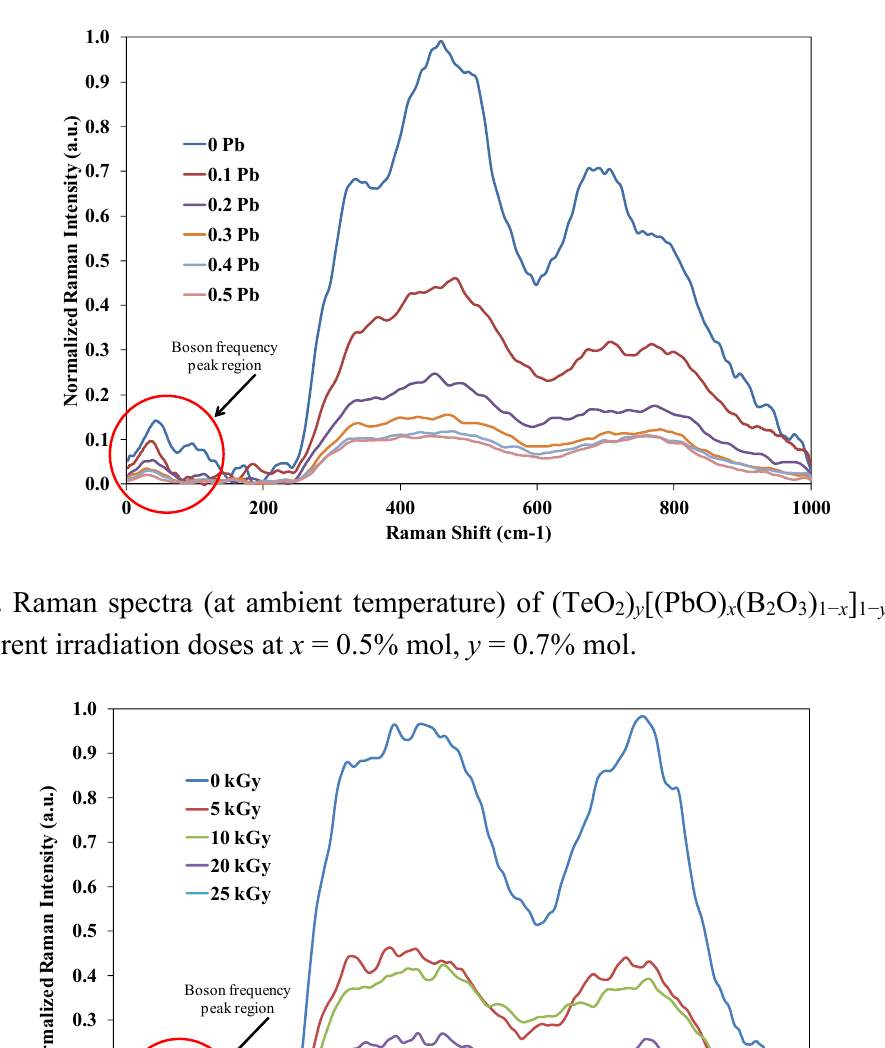
Figure 1. Raman spectra (at ambient temperature) of (TeO with different compositions before irradiation.